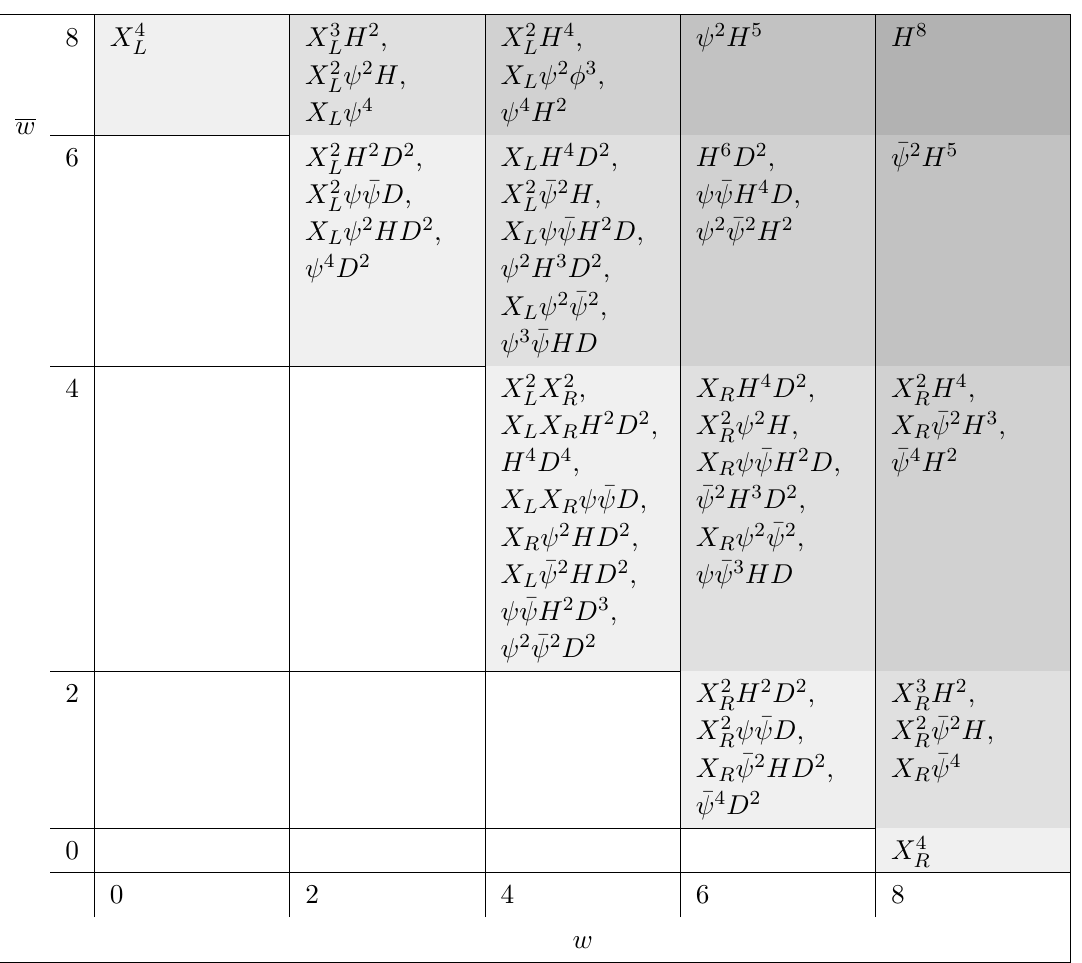
Table 19 . Weight lattice for dimension-8 operators in the SMEFT. By the non-renormalization theorem of ref. [67] a subclass of operators, j , can renormalize another subclass, i , at one-loop if w i (cid:21) w j and w i (cid:21) w j . Visually this prevents transitions down or to the